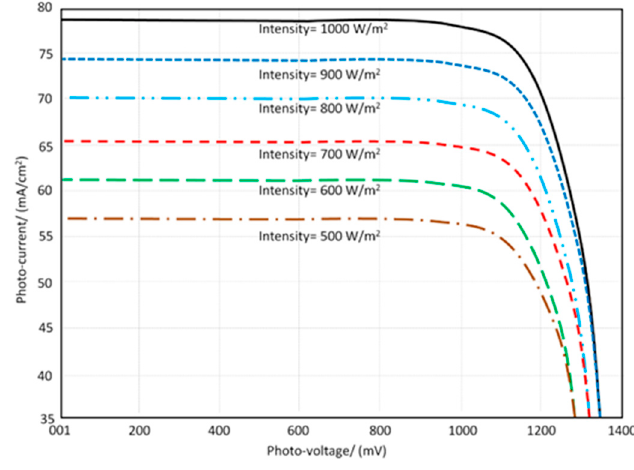
Figure 14. Solar panel performance after introducing the proposed antenna structure.